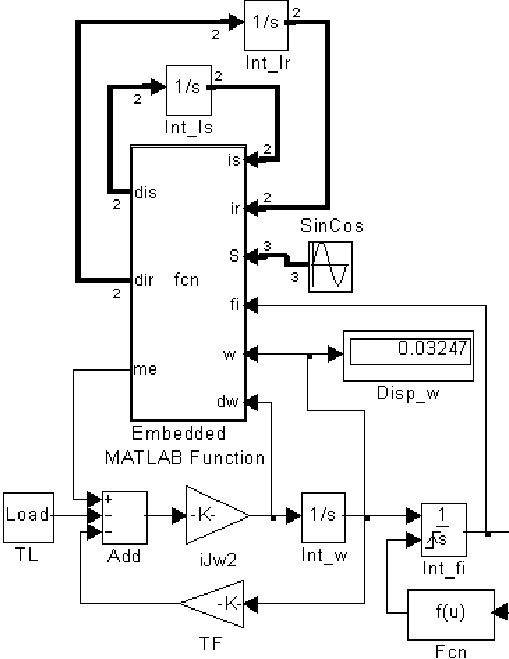
Figure 3. The model of a slip-ring motor in a Simulink program.